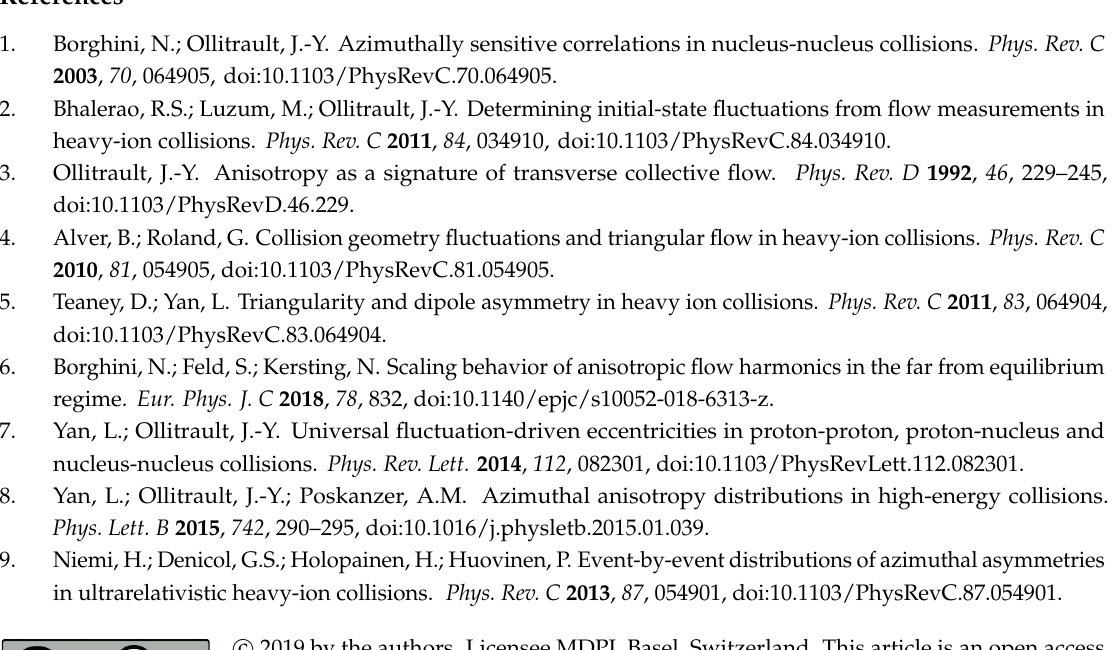
Figure 1. Plot of the normalized distribution P ( v pair relative